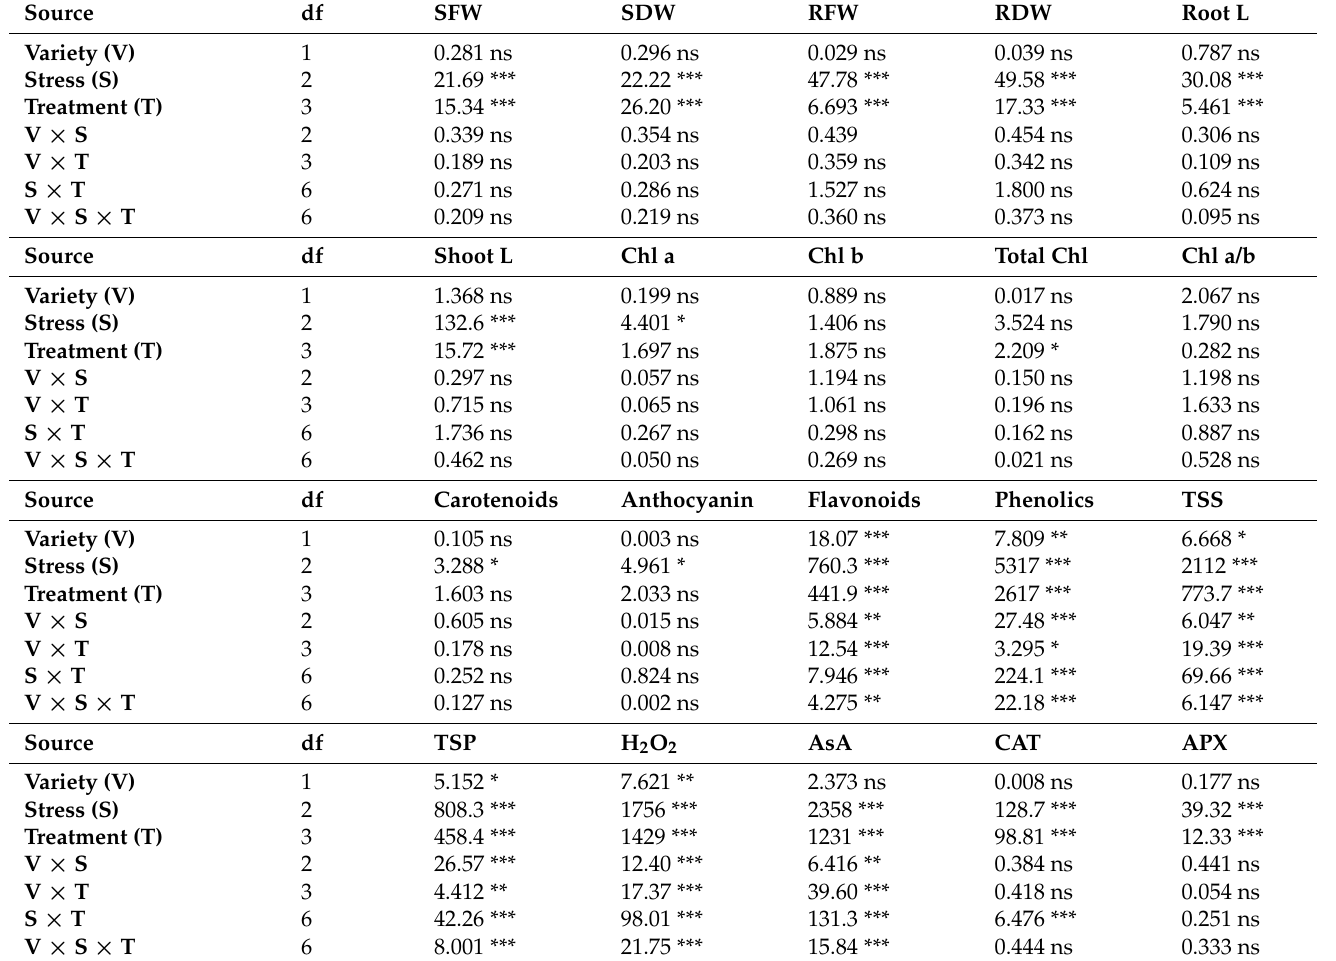
Table 3. Statistically mean squares with significant level from the three-way analysis of variance for various physiological and biochemical parameters of the wheat ( Triticum aestivum L.) plants inoculated with Bacillus subtilis , Aspergillus niger and L-proline under the control (0 mg/kg soil) and cadmium stress (40, 80 mg/kg soil) conditions.